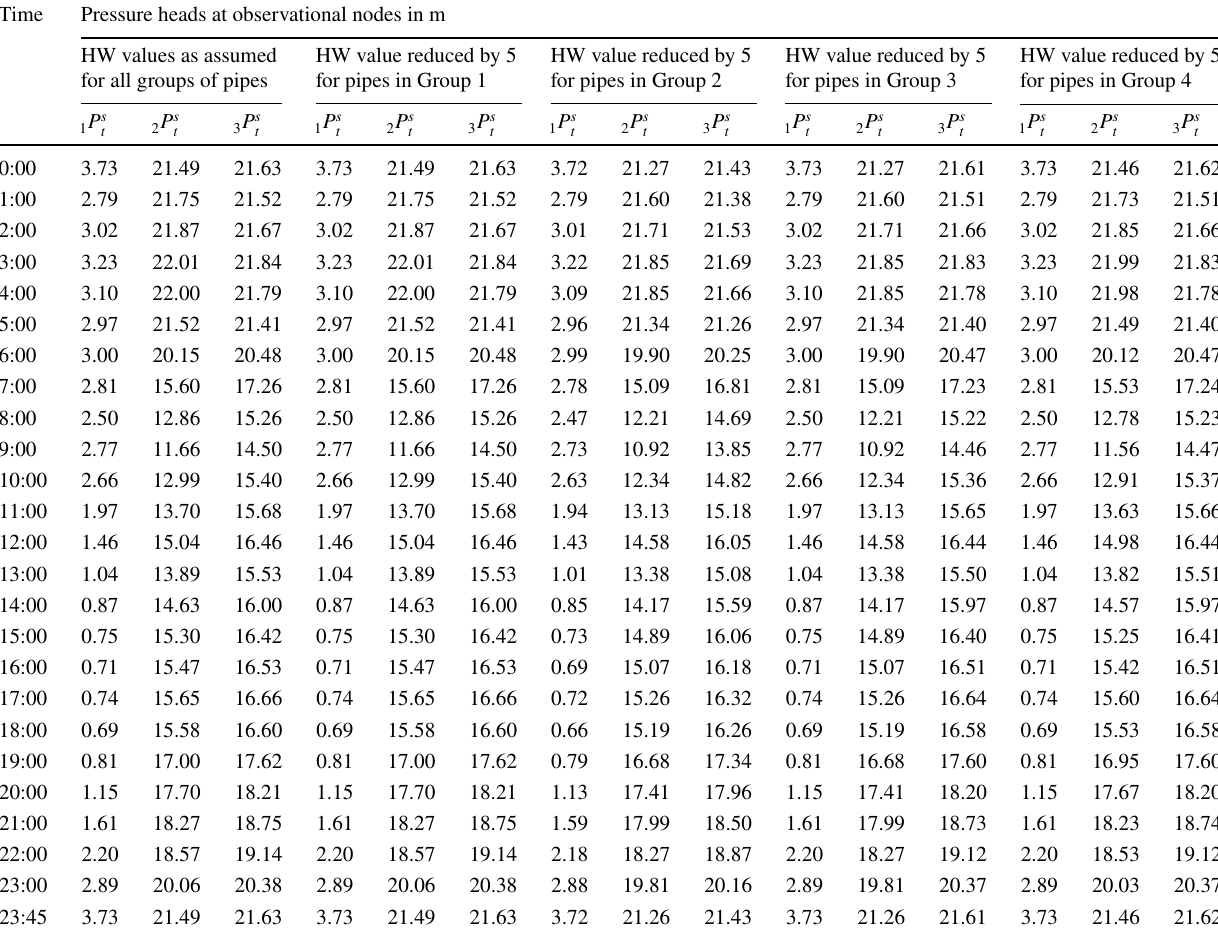
Table 3 Pressure heads at observation nodes on changing HW values for pipes in different groups one by one Time Pressure heads at observational nodes in m HW values as assumed for all groups of pipes